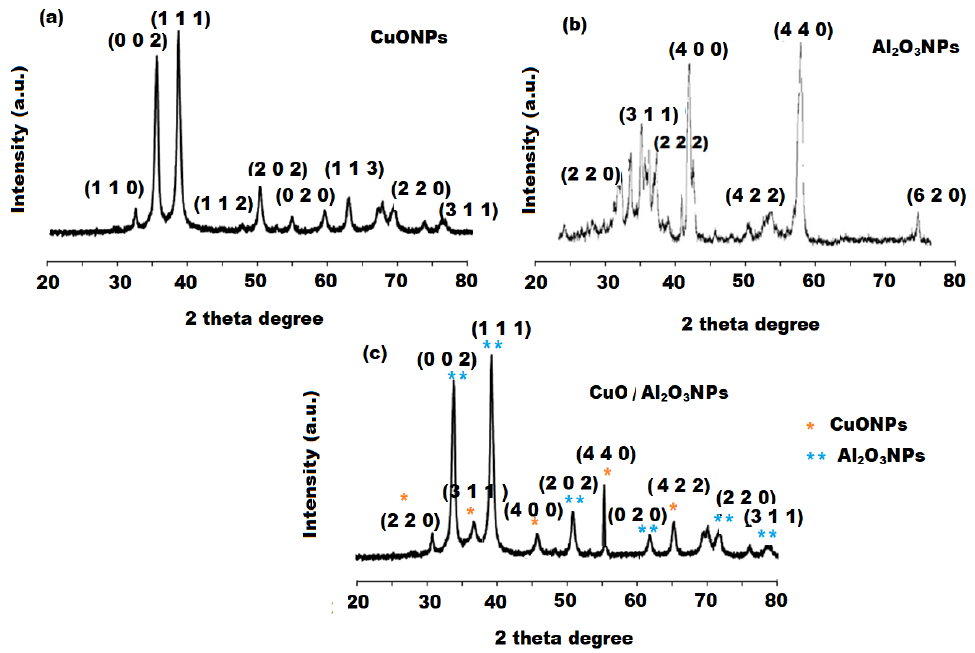
Figure 5. XRD spectra of ( a ) CuONPs, ( b ) Al 2 O 3 NPs and ( c ) CuO/Al 2 O 3 nanocomposite.